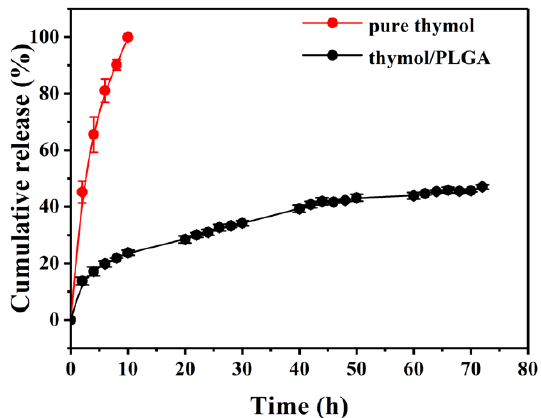
Figure 6. In vitro release of free thymol and thymol-loaded PLGA microparticles in phosphate buffer solution at 25 °C. Error bars indicate the standard deviation of the mean. 3.7. Antibacterial Activity Thymol has been shown to possess antimicrobial activity toward a large range of microorganisms [3]. The antibacterial activities of thymol-loaded PLGA microparticles were tested